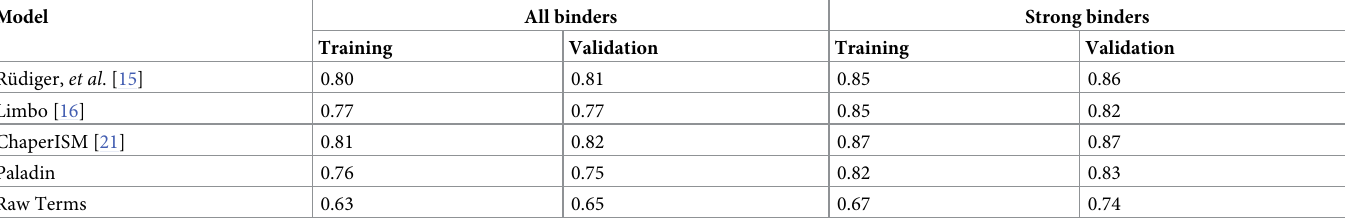
Table 2. Area under the ROC curves (Fig 5). The curves were based on the discrimination of all binders from non-binders, and of only strong binders from non- binders. Model All